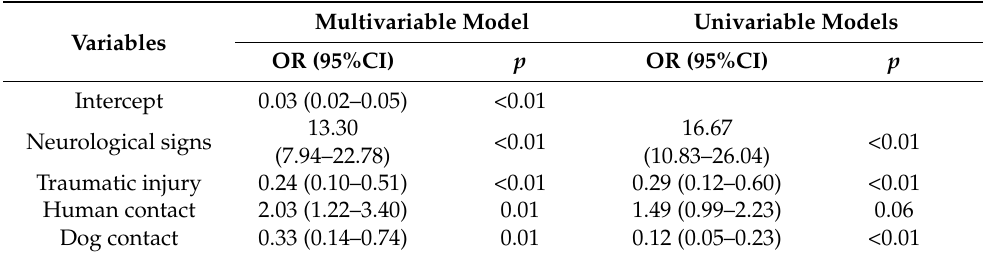
Table 4. Effects of neurological signs, traumatic injury, human and dog contact on infection status.